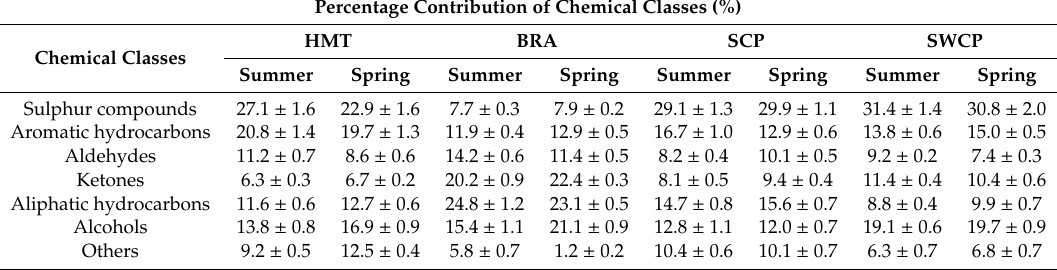
Table 2. Average percentage contribution of chemical classes at each area in WWTP under investigation (HMT—hall of mechanical treatment, BRA—biological reactors area, SCP—sludge composting piles, SWCP—solid waste composting